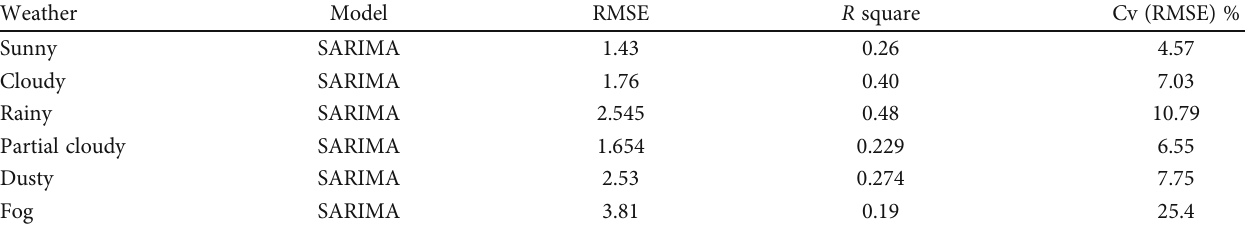
Table 4: RMSE and R square values for respective weather parameters of SARIMA model.